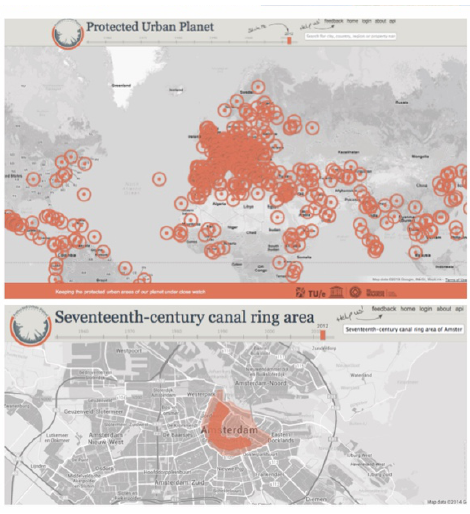
Figure5 PUP Global Map and detail of protected area of the city of